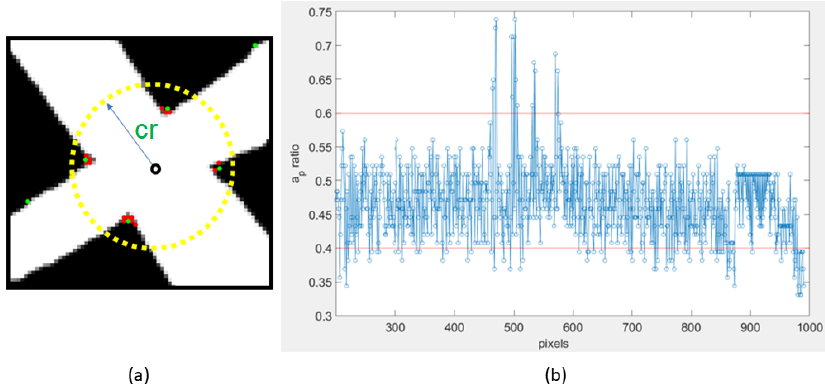
Figure 4. The detection of feature points of bacteria cells. ( a ) Corner detection sketch map with two overlapping cells: the red markers are the extraction of corner points using the circular template approach [61] and the green markers are the detection of corner points using the Harris corner detector [42]. The yellow dashed circle shows the cr radius of the branching point (the center of a circle). ( b ) Corner point detection with the circular template approach. The x -axis represents the a p ratio and y -axis represents the boundary pixels. The two red horizontal lines are the specified intensity range and ( b ) shows that the pixels have exceeded the threshold